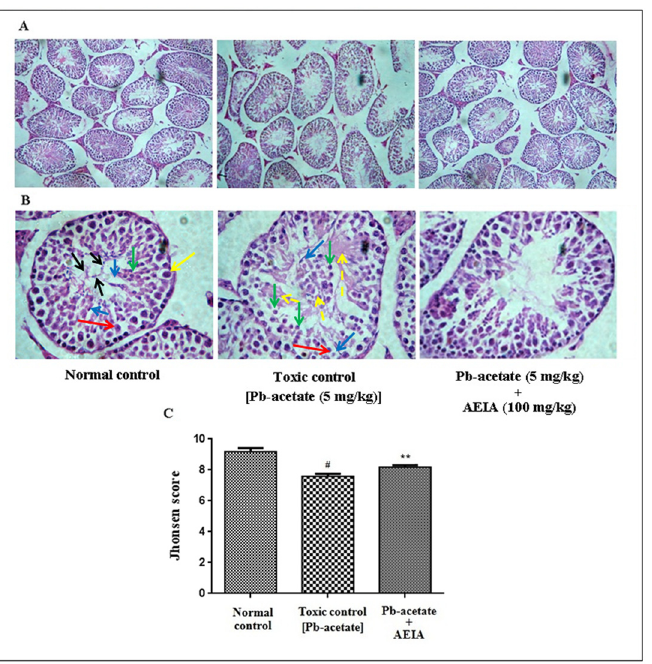
Fig 11. Histological sections 100 x (A) and 400 x (B) of testes of experimental mice in the absence (Pb- acetate) and existence of AEIA (Pb-acetate + AEIA). Untreated mice were kept as normal control to compare the structural changes caused by Pb-acetate. The section of normal control illustrating the typical structure of seminiferous tubule at Johnsen score of ~ 9 – 10 showing all stages of spermatogenesis. Yellow arrow represents spermatogonia near to the basement membrane; Red arrow represents primary spermatocytes; Green arrow represents round spermatids; Blue arrows represent elongated spermatids; Black arrows represent mature spermatozoa. Pb-acetate intoxicated group exhibited seminiferous tubule showing Johnsen score of ~ 6 – 7. Tubule contains primary spermatocytes (red arrow); round (green arrows) and elongated (blue arrows) spermatids, and cloudy abnormal spermatozoa (yellow dotted). AEIA treated section exhibited Johnsen score of ~ 8 – 9. C. The Johnsen score was determined (400 X, containing one seminiferous tubule). Values are expressed as mean ± SE, (n = 60). # Values differ significantly from normal control (p < 0.01). ** Values significantly differed from Pb-acetate control (P <